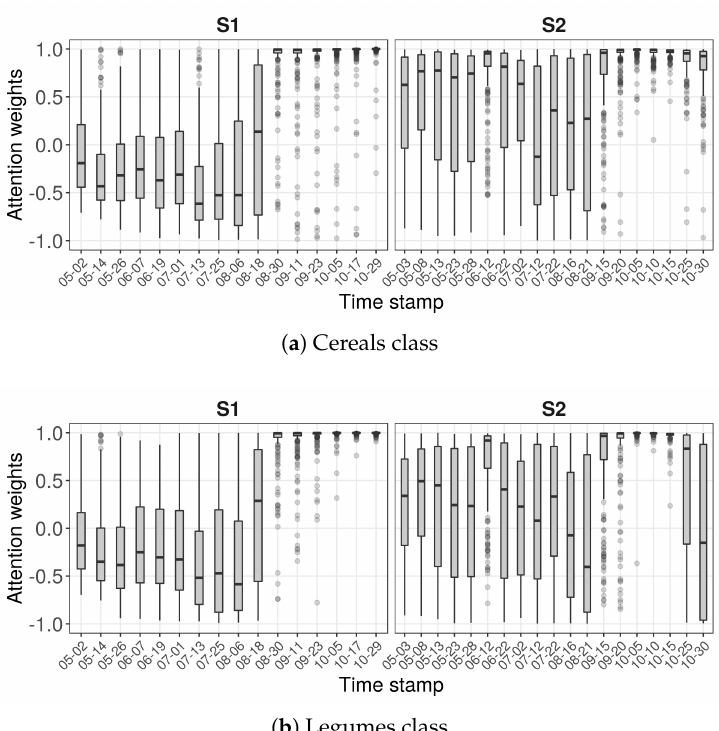
Figure 16. Box plots of the attention weights on cereals and legumes land covers considering the multi-source time series.